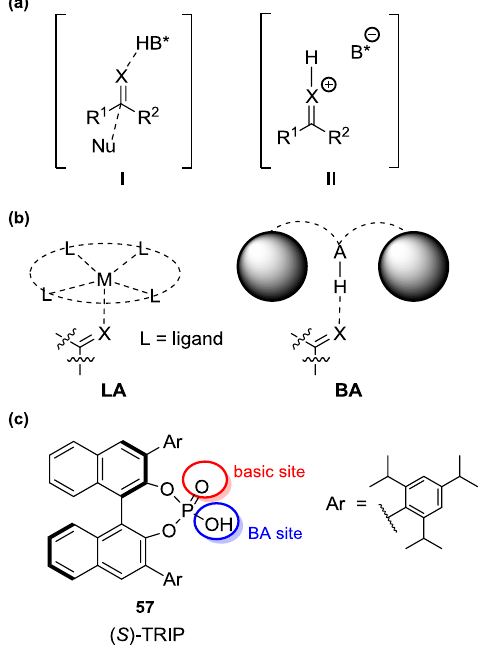
Figure 15. (a) Transition states in general acid catalysis (I) and in speci fi c acid catalysis (II); (b) Lewis acid (LA) and Brønsted acid (BA) catalysts; (c) ( S )-TRIP [( S )-3,3 ′ -bis(2,4,6-triisopropylphenyl)- 1,1 ′ -binaphthyl-2,2 ′ -diyl hydrogen